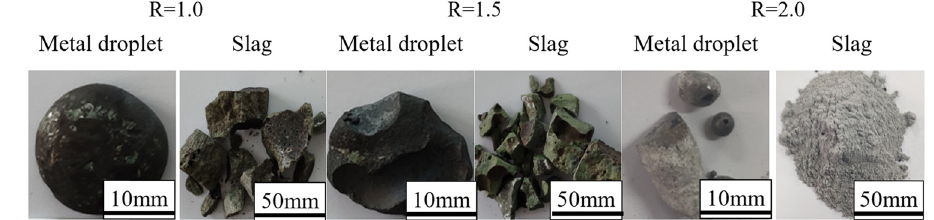
Figure 4: Images of metal and slag after